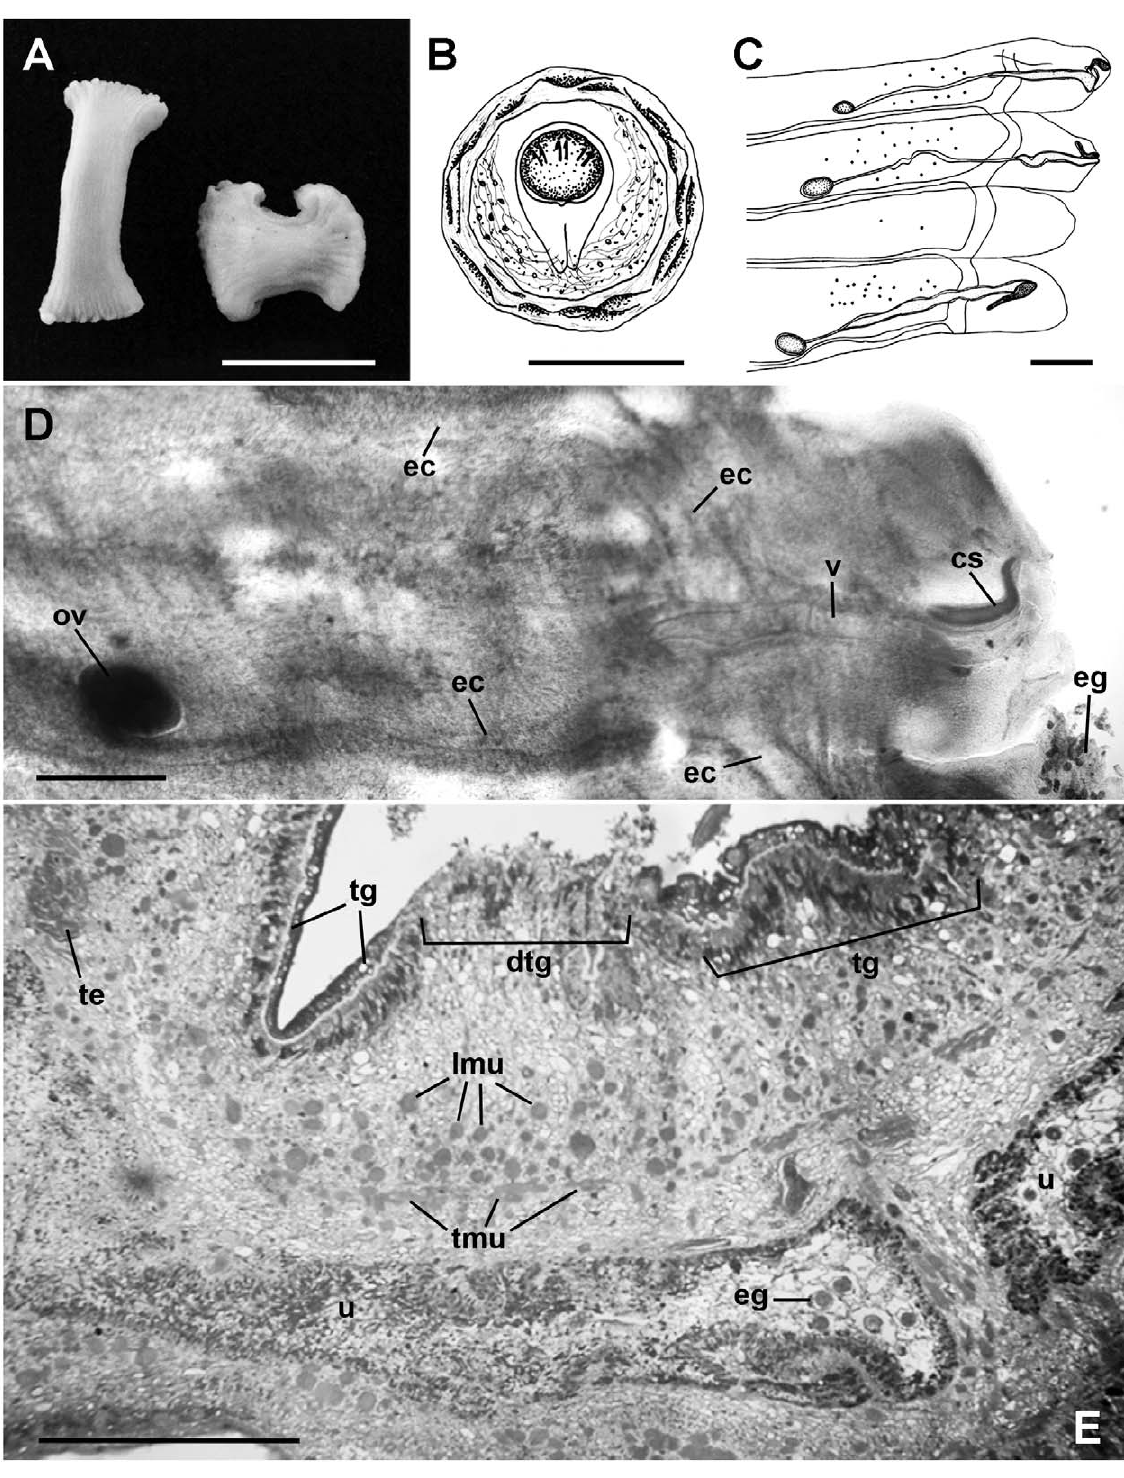
Figure 1. Morphological features of Bertiella sp. expelled by a 4-year-old girl of the Amazon region. (A) Macroscopic view of proglottids (Bar=1 cm). (B) Egg illustration showing thick shell, albuminous layer, piriform apparatus, and oncosphere (Bar=2.5 m m). (C) Mature proglottids illustration showing genital pores in an irregular, alternating arrangement, unlobed ovaries, vagina, cirrus sac, and excretory canals (Bar=1000 m m). (D) Gravid proglottids under compression showing the ovary (ov), vagina (v), cirrus sac (cs), and excretory channels (ec). Numerous eggs (eg) were observed outside of proglottids (Bar=500 m m). (E) Proglottids histological section, showing few eggs (eg) in the uterus (u). The tegument presented intact areas (tg) and discontinuous portions (dtg). Transversal (tmu) and longitudinal (lmu) muscles and testes (te) were also observed (Bar=200 m m).